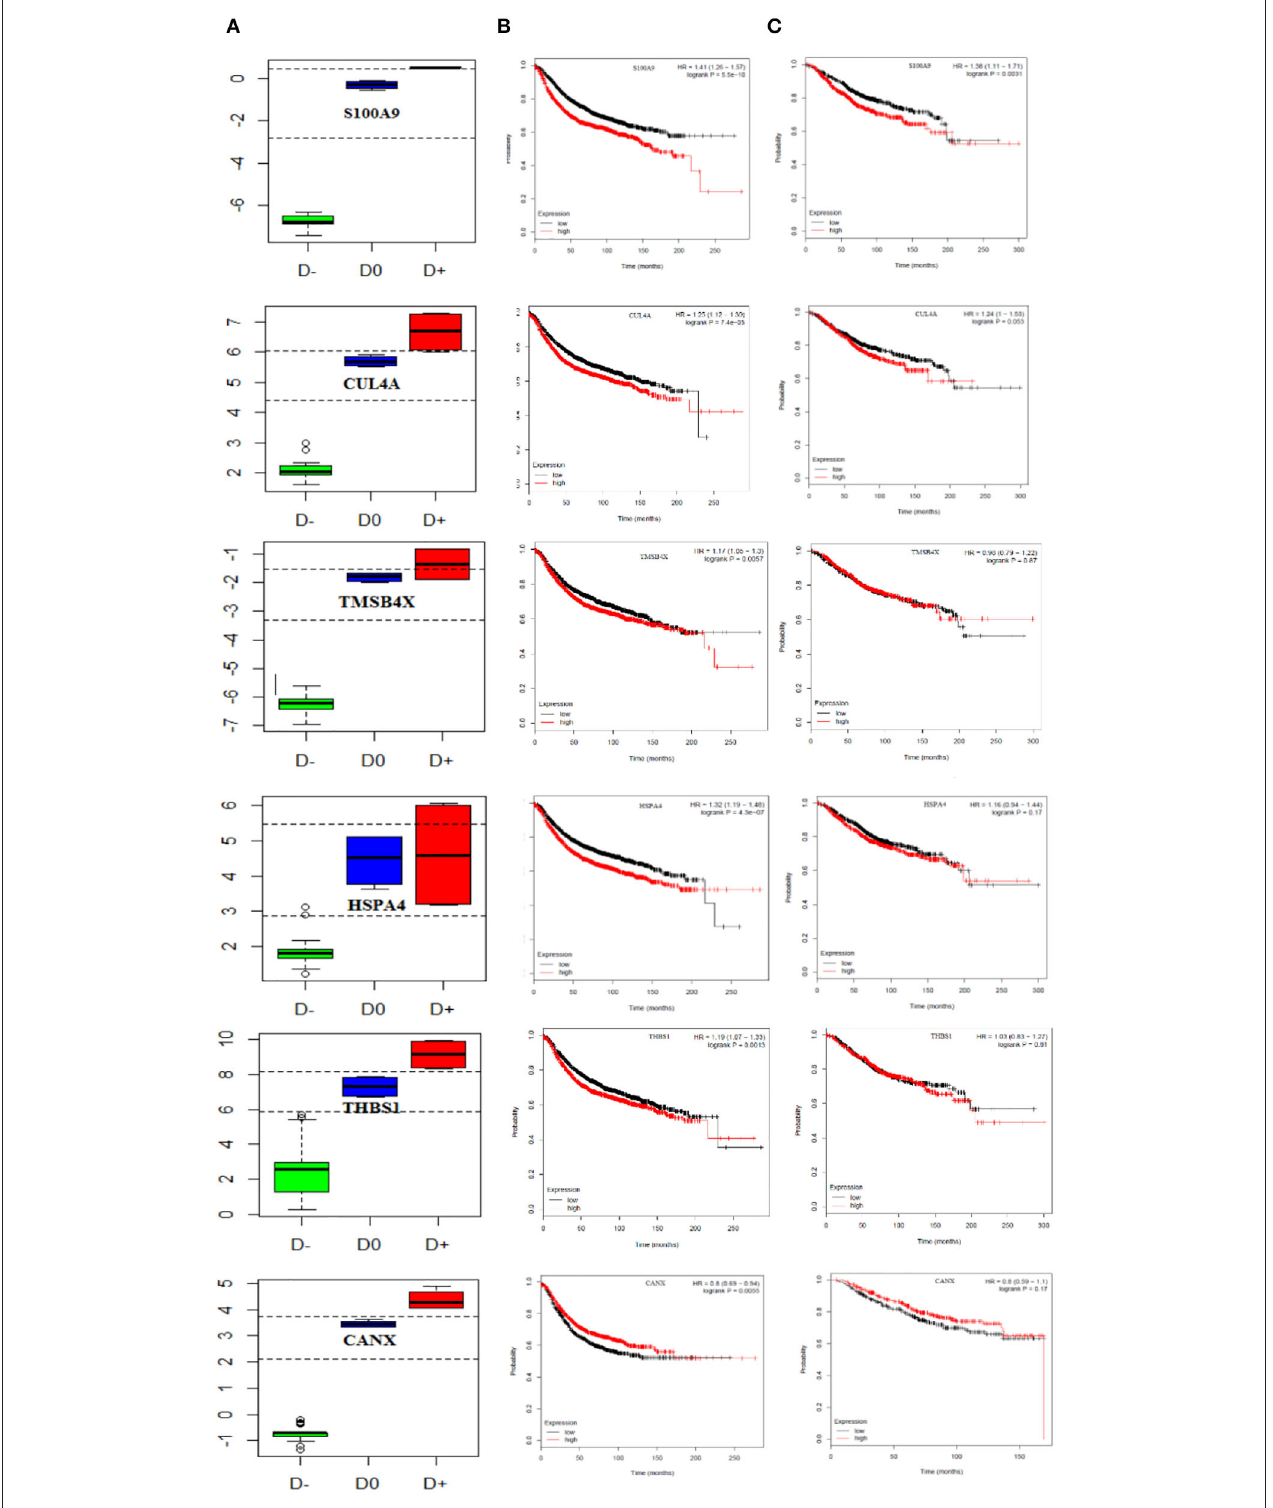
FIGURE 6 | Prognostic curve of the related PBMC gene signatures. (A) Boxplot of the Youden index calculated for PBMC gene signatures, S100A9, SRSF6, THBS1, CUL4A, and CANX, could accurately distinguish metastatic and primary breast cancer patients from healthy objects. D − refers to metastatic breast cancer patient, D 0 healthy subjects, and D + primary breast cancer patient cut-points (optimal cut-points indicated in dashed lines). Kaplan–Meier curves show (B) relapse-free survival in breast cancer patients and (C) overall survival and (TCGA data set). The red and black curves represent the high and low expression levels, respectively. p -values are shown at the upper-right corner. HR, hazard